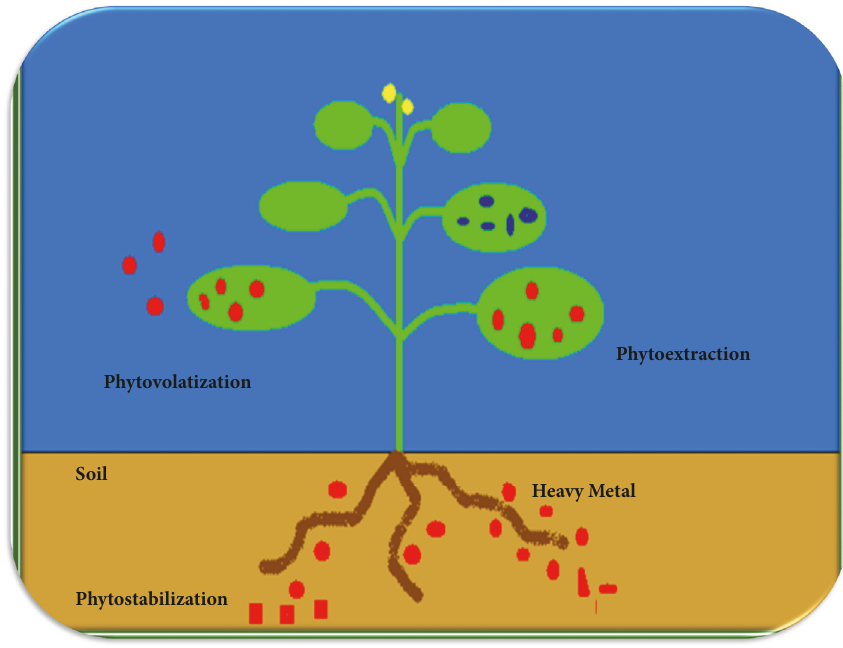
Figure 1: Phytoremediation mechanism adopted by plants to remediated heavy